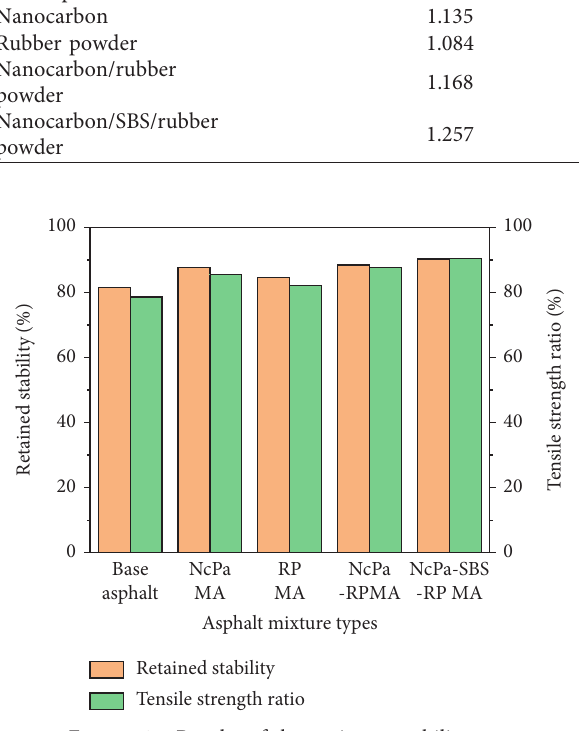
Figure 17: Results of the moisture stability